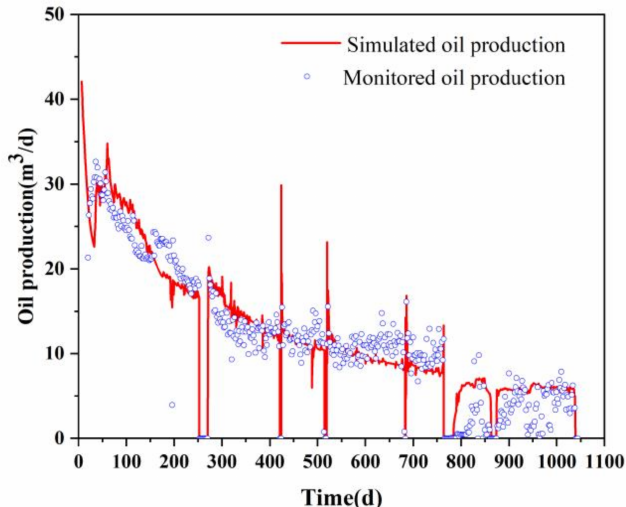
Figure 3. Oil production history